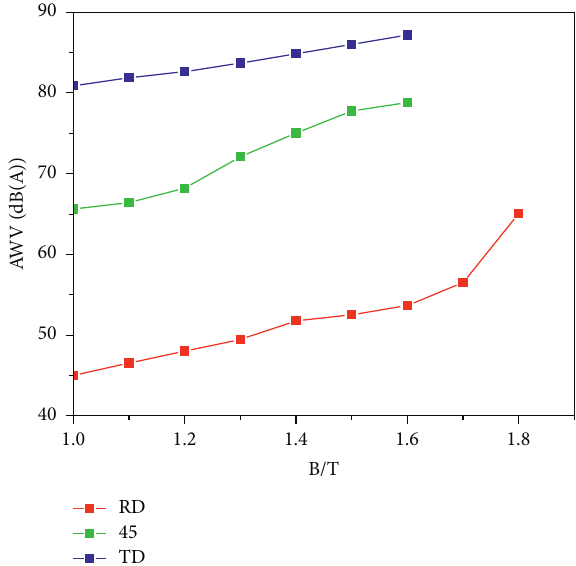
Figure 11: AWV noise curve of grain-oriented SSS in various